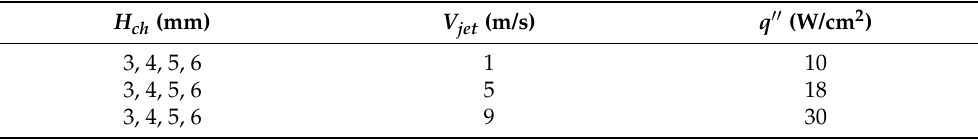
Table 4. H ch , V jet , and heat flux conditions for numerical analysis.